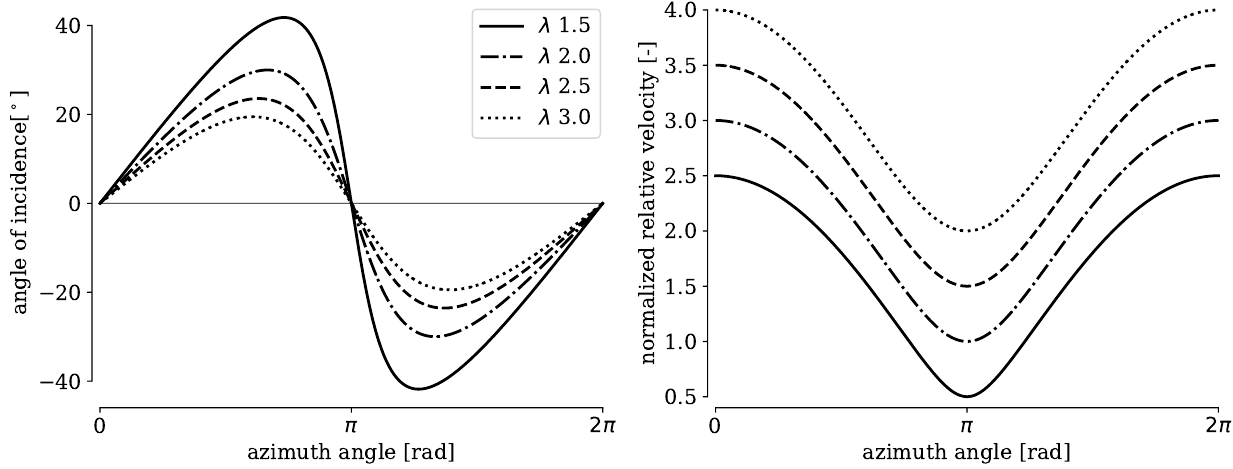
Figure 2. Alternating angle of incidence α ( left ) and relative velocity w ( right ) at blade level in dependence of azimuth angle θ and tip-speed ratio λ . The relative velocity w is normalized to the far-field velocity: w / v ∞